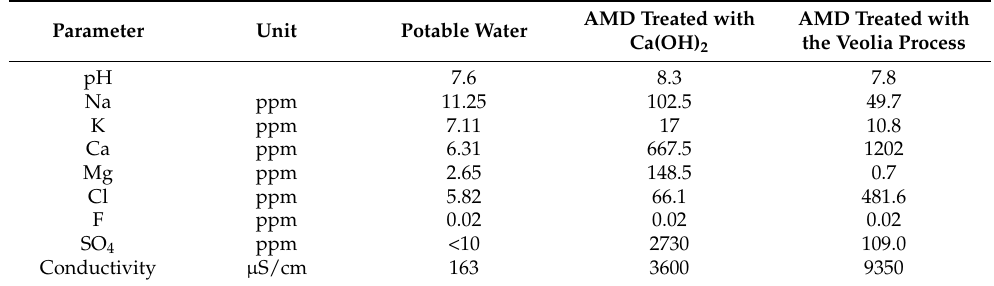
Table 5. Chemical assays of potable water, AMD treated with Ca(OH) 2 , and AMD treated with the Veolia